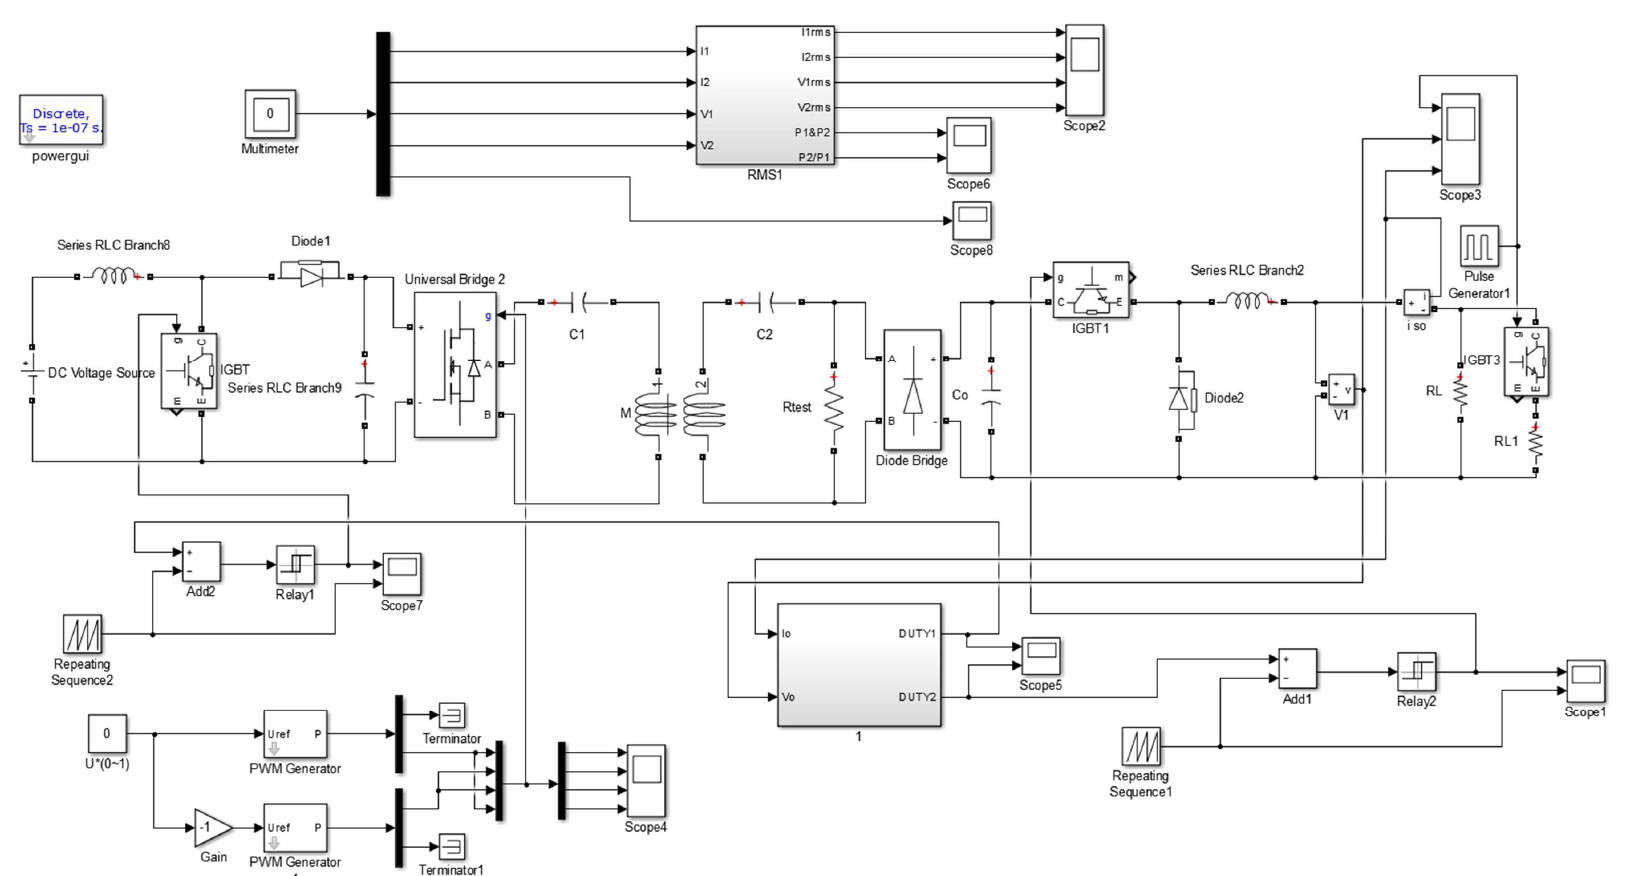
Figure 10. Simulation circuit of load adaptive control strategy.